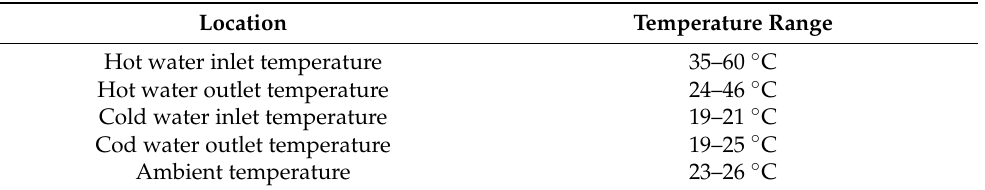
Table 1. Experimental temperature